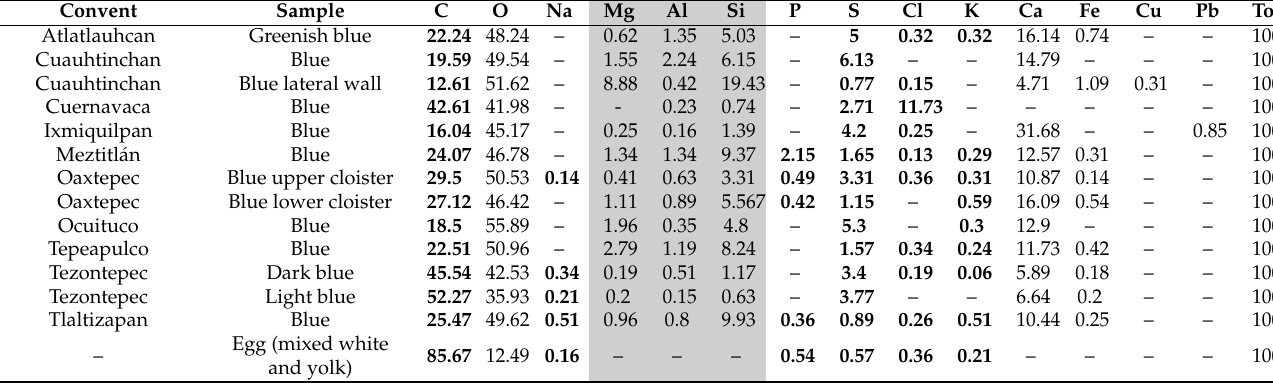
Elements related to palygorskite and sepiolite are highlighted with grey shading, while elements possibly related to an organic binder are marked in